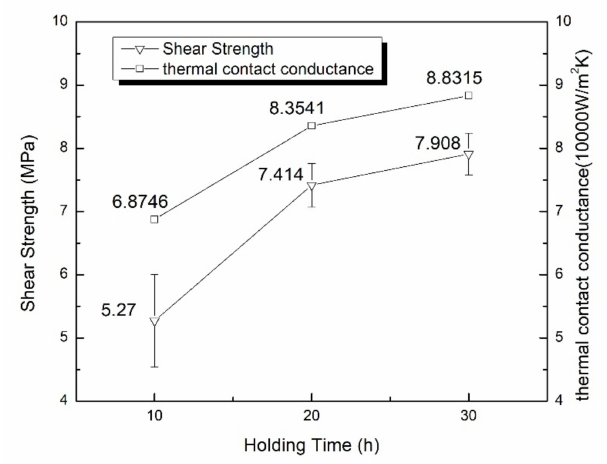
Figure 8. E ff ect of holding time on shear strength and thermal contact conductance of the joints at the bonding temperature of 100 ◦ C.